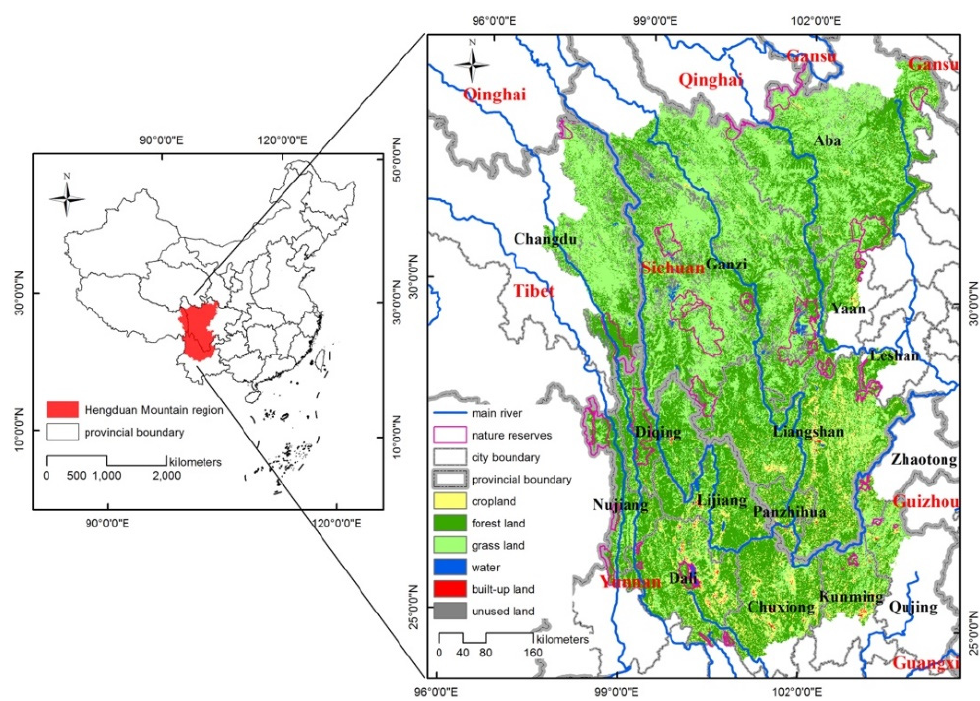
Figure 1. Location and land-use (2015) map of the Hengduan Mountain region.